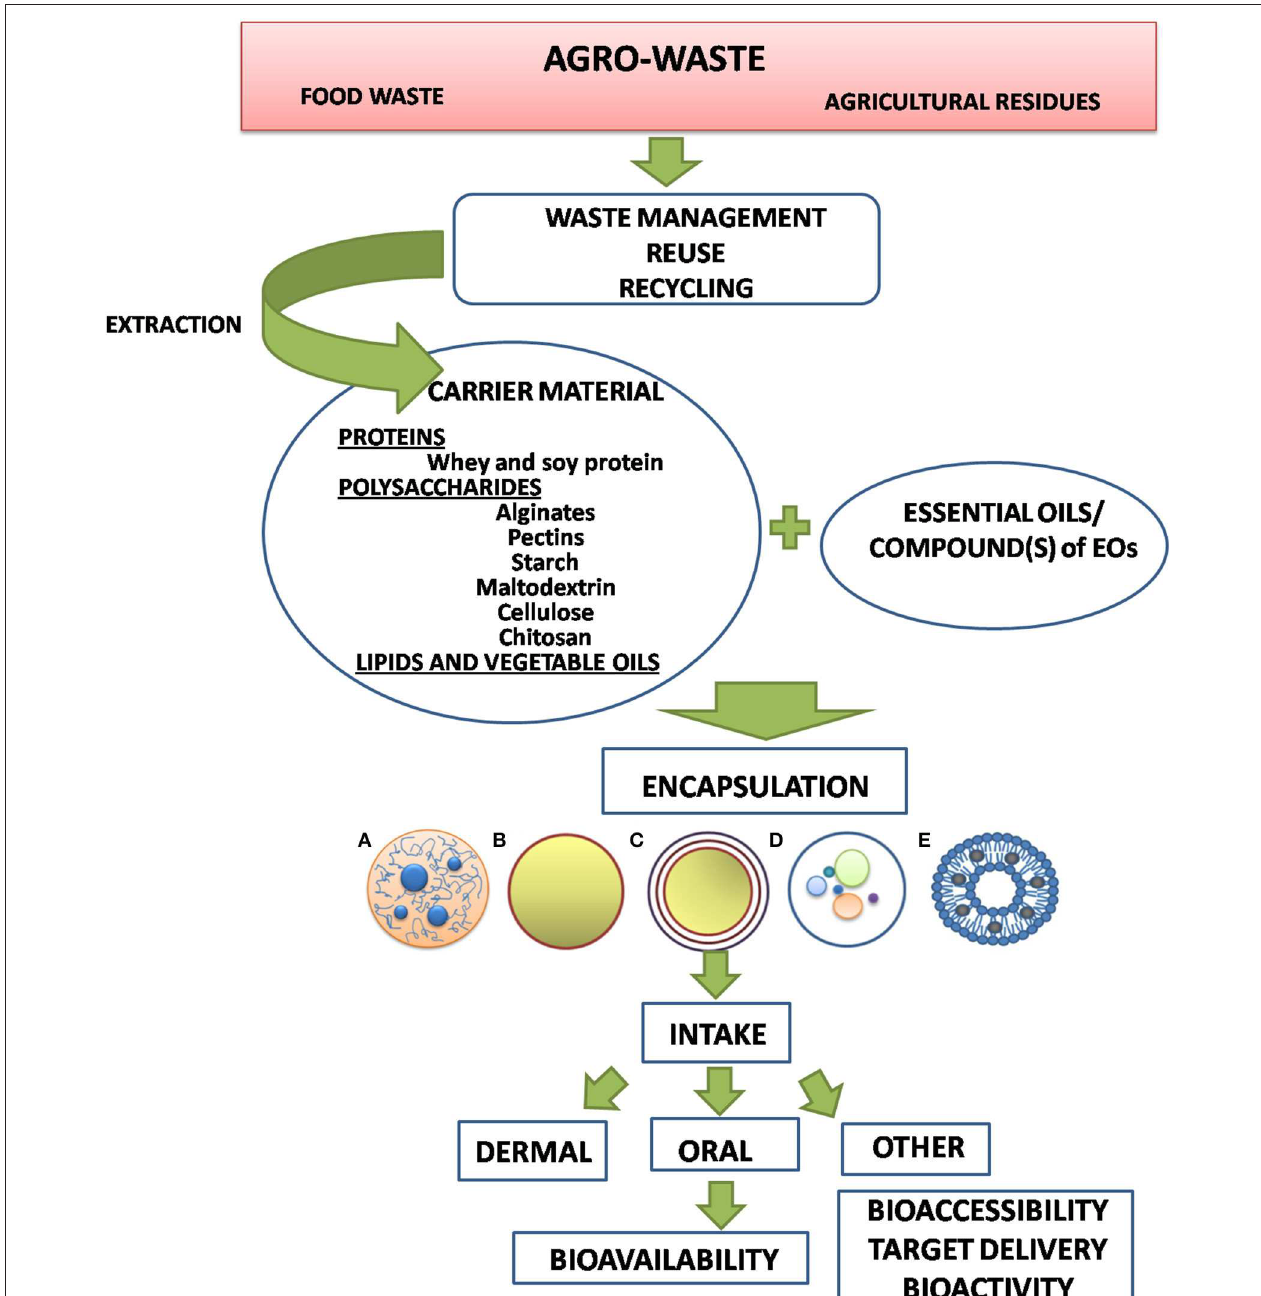
FIGURE 5 | Strategy of choice for the optimal carrier performances of encapsulation of EOs for biomedical application and enhanced bioavailability. (A) hydrogel bead, (B) monolayer capsule, (C) multilayer capsule, (D) composite bead, (E) liposome.